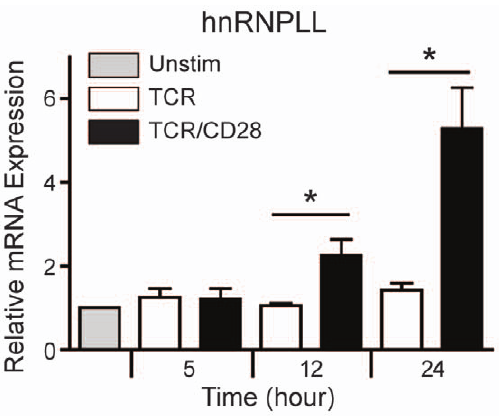
Figure 5. Enrichment of hnRNPLL splicing targets in genes alternatively spliced in T cells activated with TCR/CD28. Representation of the overlap of hnRNPLL target gene transcripts from Oberdoerffer et al. [14] with the genes displaying significant alternative splicing in anti-CD3/CD28 versus anti-CD3 stimulation conditions. Statistical significance of the overlap was calculated using the hypergeometric distribution.